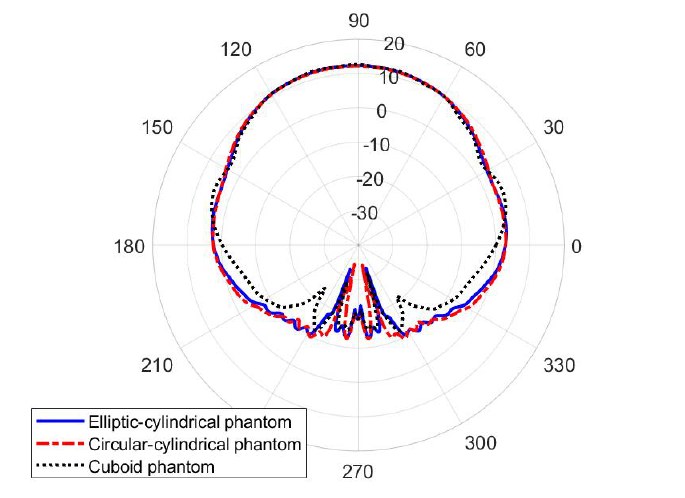
Figure 11. Influence of the human phantom cross-section on the radiation pattern in the E-plane ( xy -plane) of the textile slotted waveguide array. Radial scale is in dB, angular is in degrees. The smart belt type of application (in which the slots are horizontally positioned) suggest two approaches to the design—using a Distributed Antenna System (DAS) ap- proach [25], where the slots are distributed along the smart belt, or using single slot antennas (it is enough to have two of them, each radiating on each side of the body). In the first case, since the distance of the slots is not large enough (like it is assumed in the DAS approach), the radiation pattern has many nulls, see Figure 12. However, single slot design offers much better coverage. In order to establish an efficient antenna, we have designed a transverse slot antenna, together with the short circuit at the distance of three-quarter of the guided wavelength, see Figure 13a. The optimized dimensions are: l = 26 mm, w = 11.8 mm, and d sc = 41.4 mm (as before, the optimization is based on minimizing the magnitude of S 11 parameter at central frequency 5.85 GHz). The radiation pattern of such an antenna, in the presence of the circular-cylindrical phantom, is shown in Figure 14.